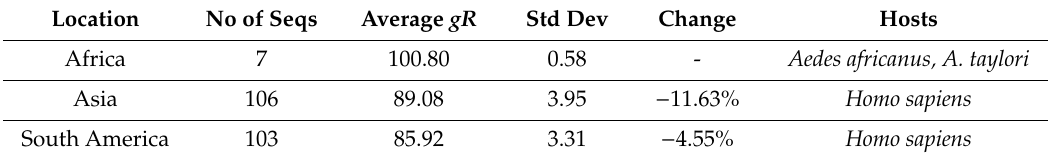
Figure 3. The 2D graphical representation of the Zika virus whole genome (GenBank Locus ID KY241706), methodology as per [75]. The axes are assigned as follows: A (adenine) to the negative x -axis, c (cytosine) to positive y -axis, g (guanine) to positive x -axis and t (thymine) to negative y -axis. Table 4. gR values of all sequences of the Zika virus genome with 10,272 identified bases and selected hosts each, continent